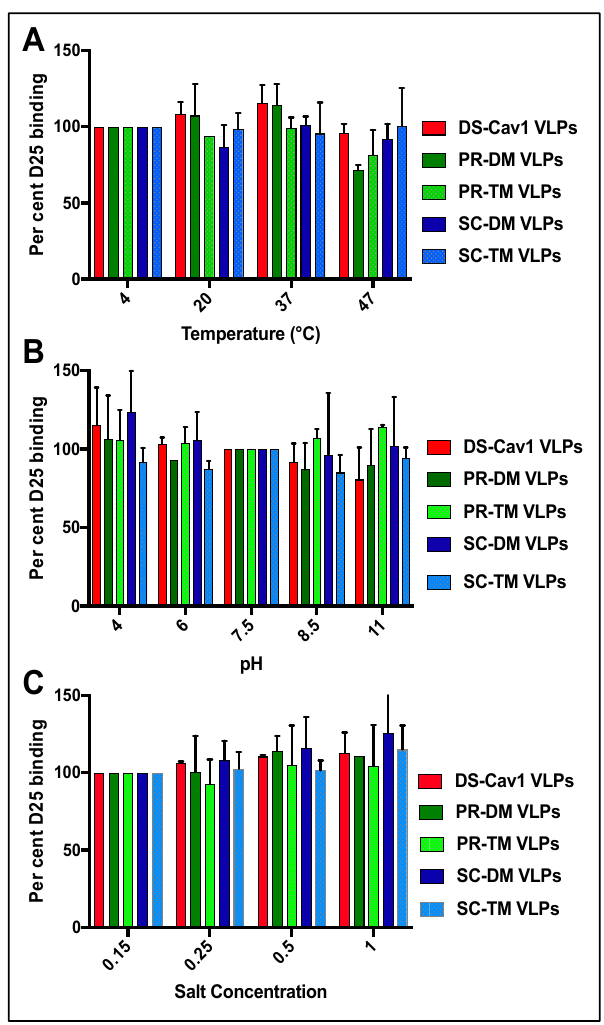
Figure 4. Stability of pre-fusion F conformation in VLPs. Equivalent amounts of F protein in VLPs were incubated for one hour at the temperatures, pH, or salt concentrations indicated. The binding of mAb D25 to the VLPs was quantified using anti-human IgG coupled to HRP. Results are presented as mAb 25 bound at each condition as a percent of the binding at 4 °C (panel A ), or pH 7.5 (panel B ), or 0.15 M salt (Panel C ). Results are the mean with standard deviations of three separate determinations. Differences were not statistically significant (student t test).